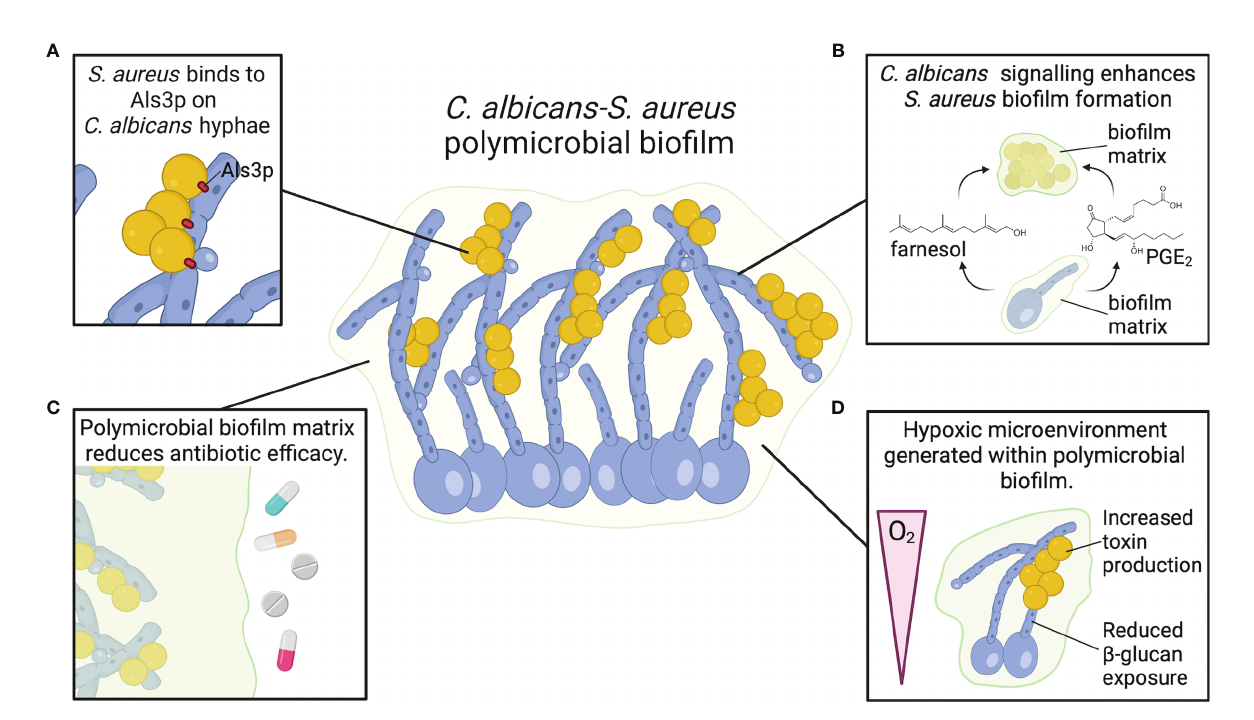
FIGURE 2 | C. albicans and S. aureus form robust polymicrobial bio fi lms. (A) S. aureus adheres to Als3 protein on C. albicans hyphae, promoting strong attachment and enhancing bio fi lm growth. (B) C. albicans chemical signals farnesol and PGE 2 enhance S. aureus bio fi lm growth and biomass. (C) Bio fi lm matrix components, particularly b -glucan, act as a physical barrier to resist antimicrobials and promote S. aureus survival. (D) C. albicans bio fi lms generate a hypoxic microenvironment that may enhance S. aureus toxin